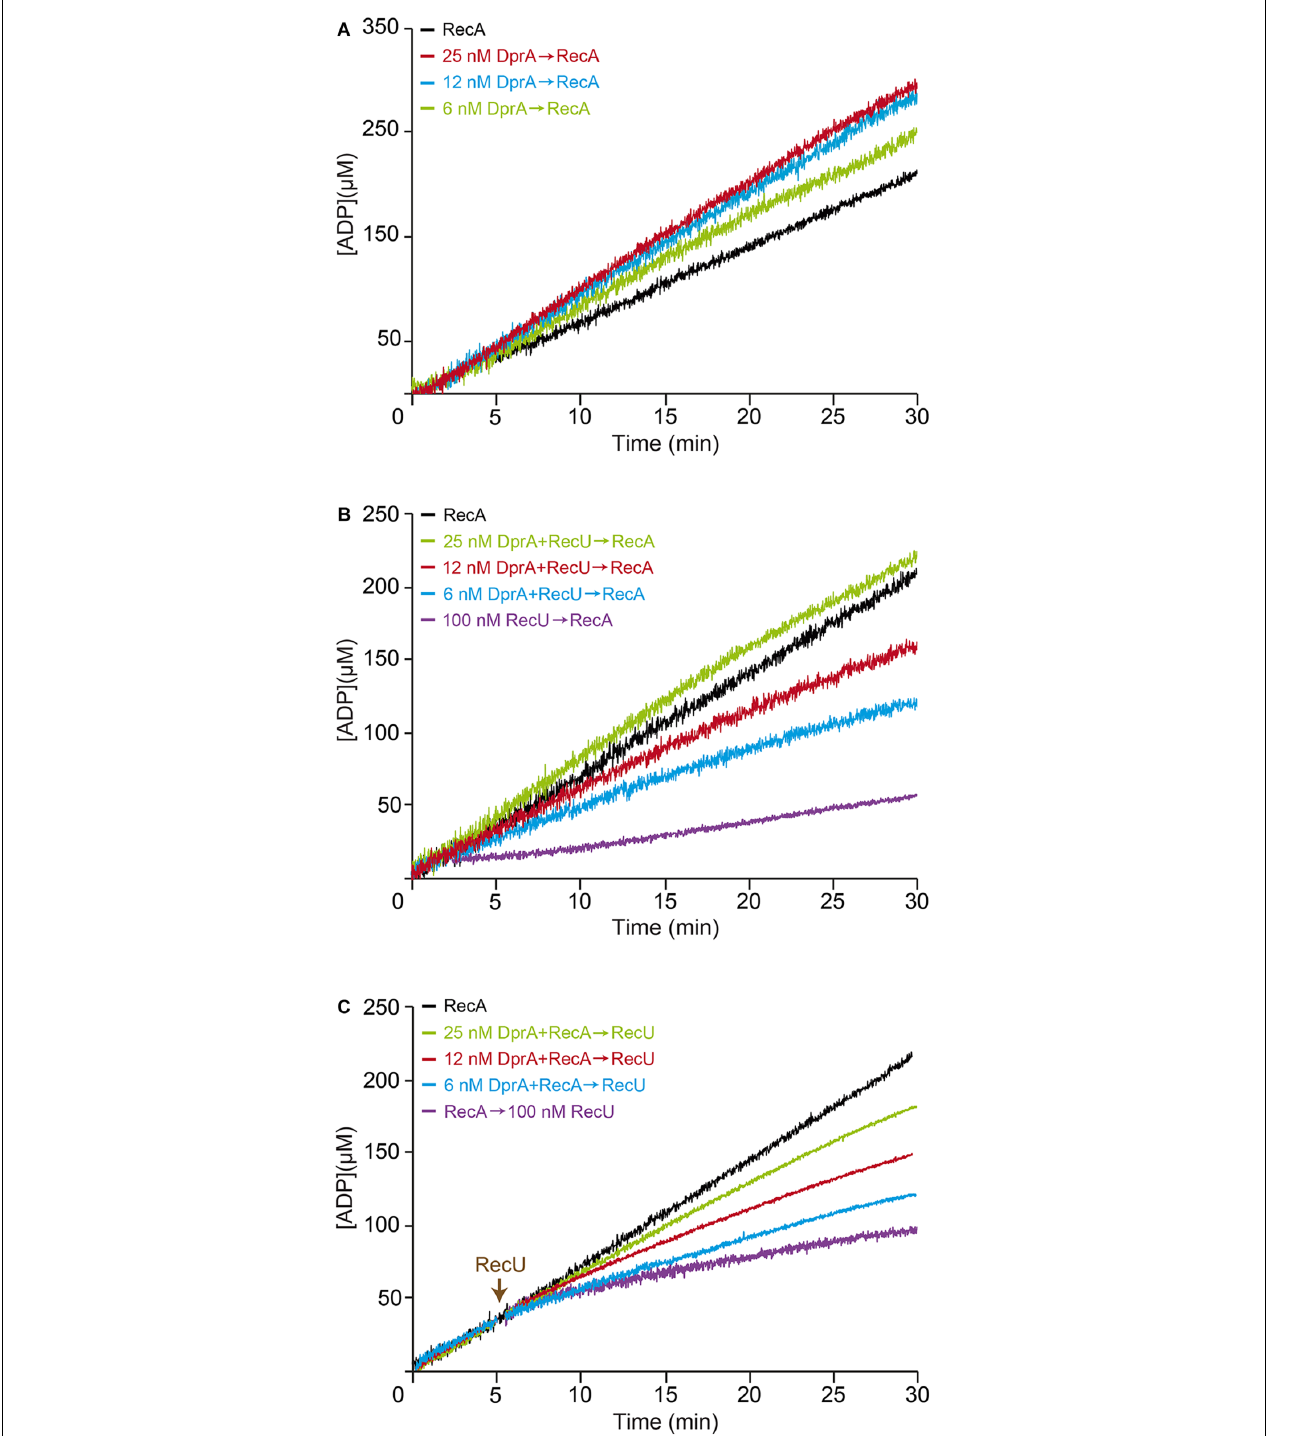
FIGURE 6 | DprA antagonizes the inhibitory effect of RecU on RecA filament extension. (A) Circular 3,199-nt ssDNA (10 µ M) was preincubated with increasing DprA concentrations (5 min, 37 ◦ C) in buffer B containing 5 mM ATP. RecA (0.8 µ M) was added and ATPase activity was measured (30 min, 37 ◦ C). (B) ssDNA was preincubated with increasing DprA concentrations and a fixed RecU amount (100 nM) (5 min, 37 ◦ C), followed by the addition RecA. ATPase activity was then measured. (C) ssDNA was preincubated with a fixed amount of RecA and increasing DprA concentrations (5 min, 37 ◦ C), followed by a fixed amount of RecU (100 nM), and ATPase activity was measured. ATPase activity was measured from the time of RecA addition. Representative graphics are shown here and quantification of the results are expressed as the mean ± SEM of > 3 independent experiments (see Table 2 ).